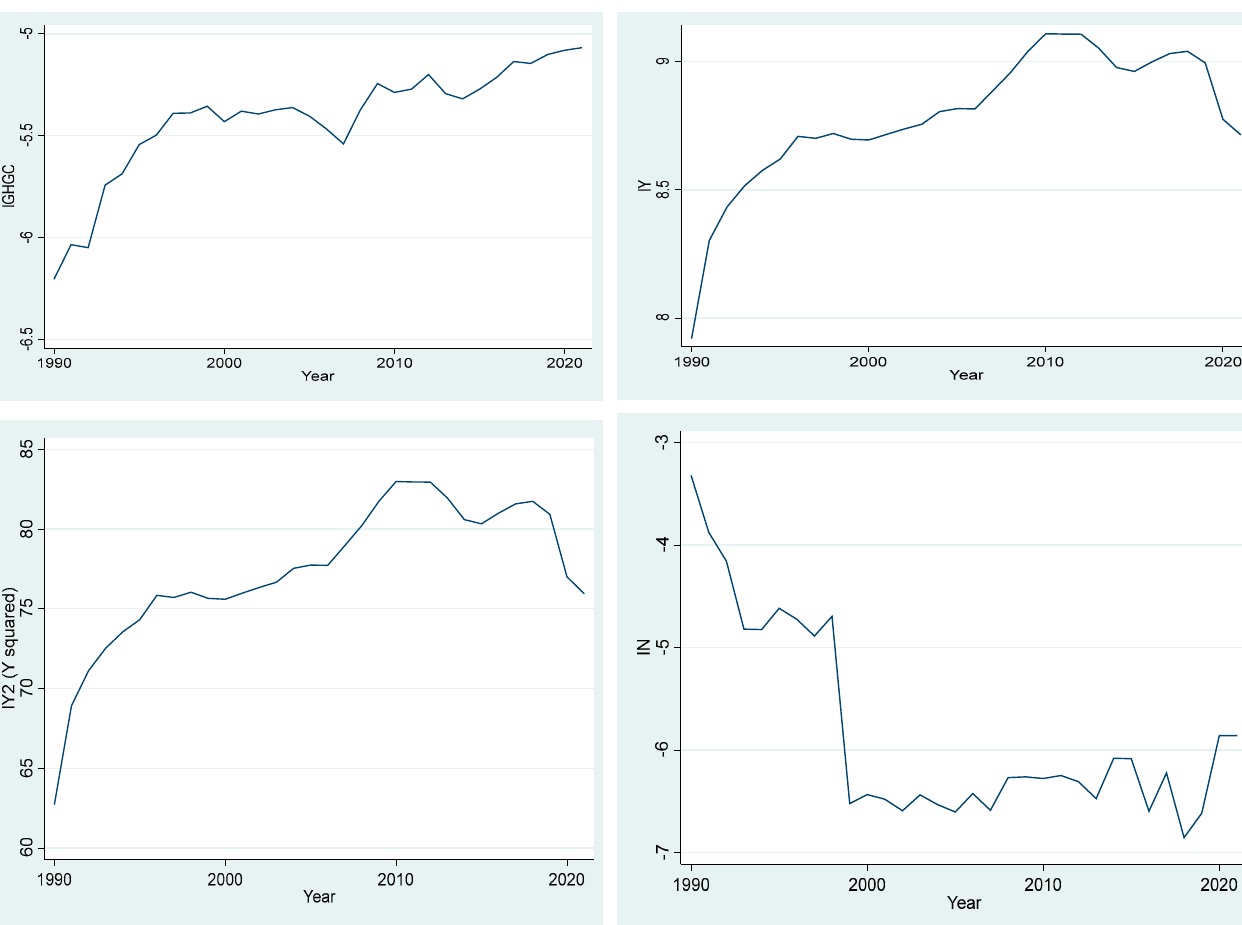
Figure A1. Time trend of variables for Sweden.